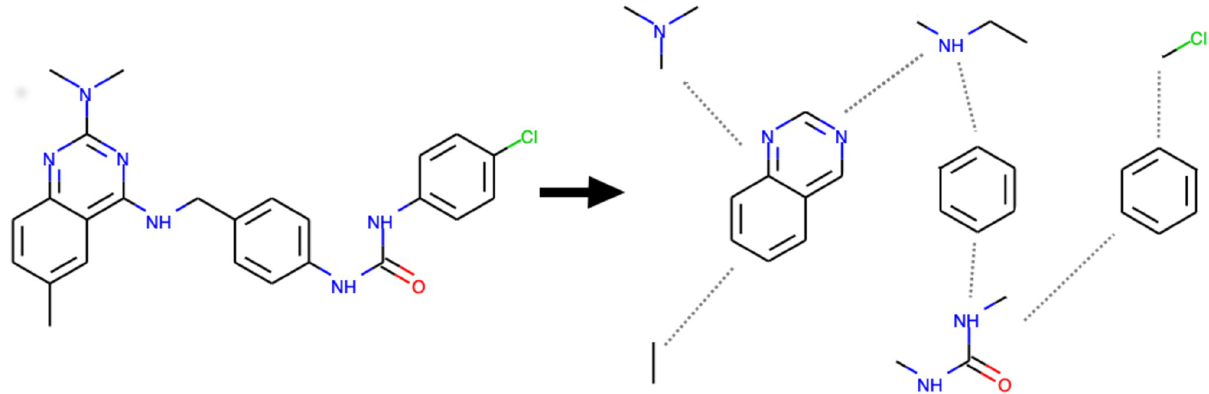
Fig 1. An example of constructing the hierarchical representation of C 25 H 25 ClN 6 O based on aromatic bonds and connected components.